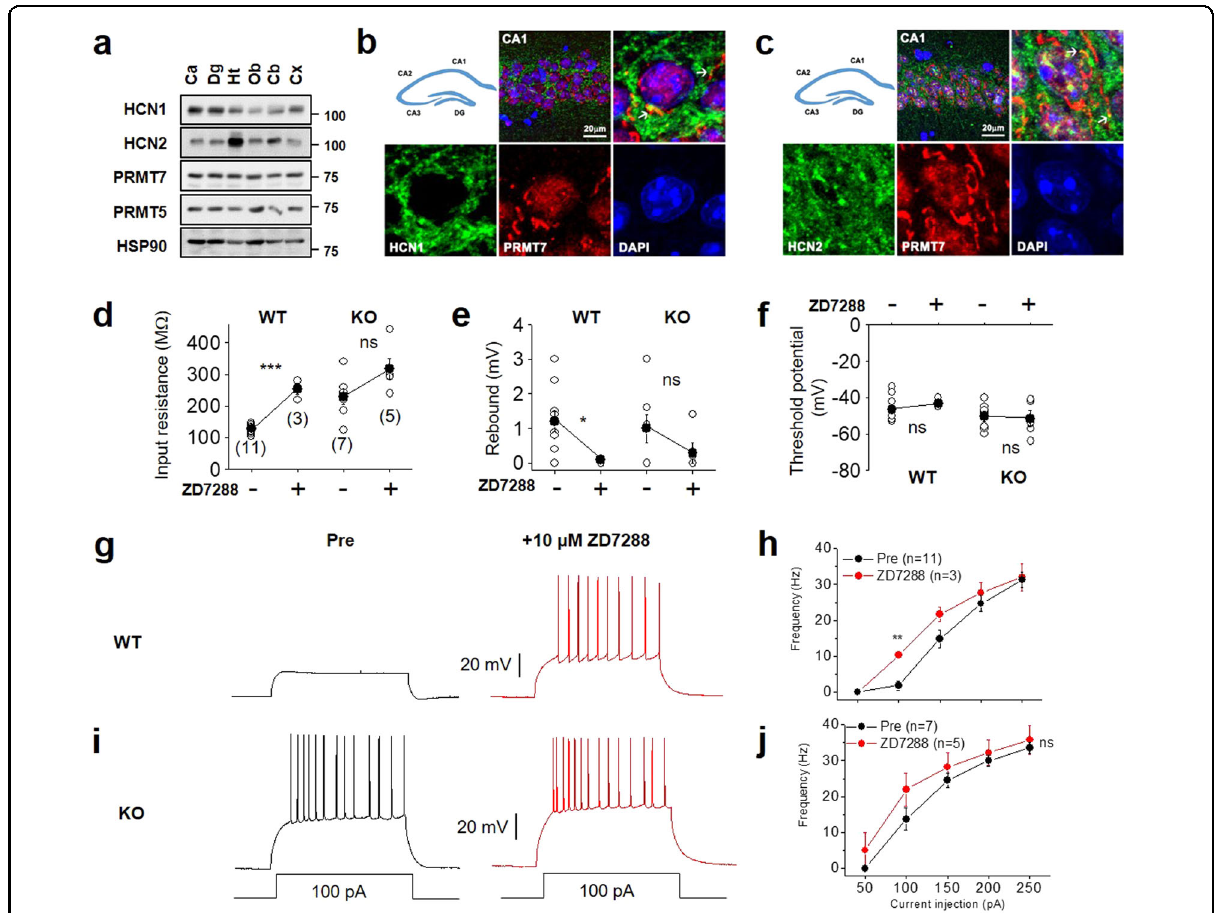
Fig. 3 PRMT7 KO renders CA1 neurons hyperexcitable by impairing I h currents. a Immunoblotting for the HCN1, HCN2, PRMT5, and PRMT7 proteins in various brain regions in 8-week-old mouse brains. Ca cornu ammonis, Dg dentate gyrus, Ht hypothalamus, Ob olfactory bulb, Cb cerebellum, Cx cerebral cortex. b , c Immunostaining of HCN1 (green, b ), HCN2 (green, c ), and PRMT7 (red) in the CA region of the 8-week-old mouse brains. Scale bar = 20 µm. d – f Changes in the input resistance ( d ), the rebound potential ( e ), and the threshold potential ( f ) in the WT and PRMT7 KO CA1 pyramidal cells in response to 10 μ M ZD7288. Each dot represents an individual pyramidal cell. Closed circles represent the mean values (error bars; S.E.M). g – j The I h -current inhibitor ZD7288 increased fi ring frequency in the WT but not in the PRMT7 KO CA1 pyramidal neurons. g , i illustrate representative traces before and after 10 μ M ZD7288 in the WT and KO pyramidal cells, respectively. Summarized data comparing the number of APs before and after the application of 10 μ M ZD7288 in the WT ( h ) and PRMT7 KO pyramidal cells ( j ). * p < 0.05; ** p < 0.01; *** p < 0.001; ns not signi fi cantly different; Student ’ s t